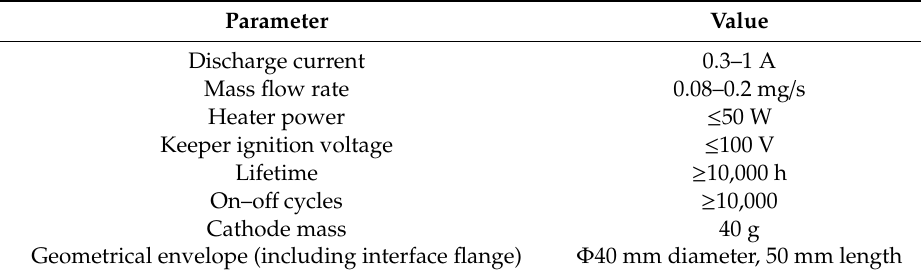
Table 1. HC1 technical